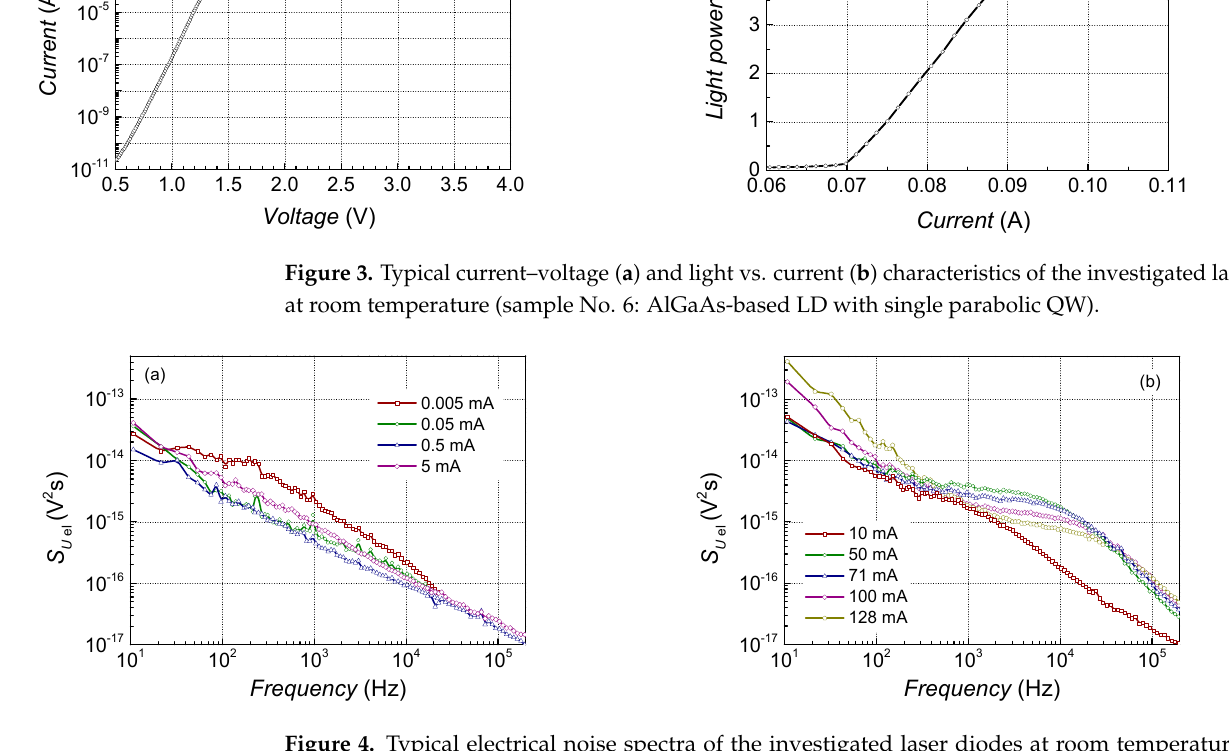
Figure 3. Typical current–voltage ( a ) and light vs. current ( b ) characteristics of the investigated lasers at room temperature (sample No. 6: AlGaAs-based LD with single parabolic QW).